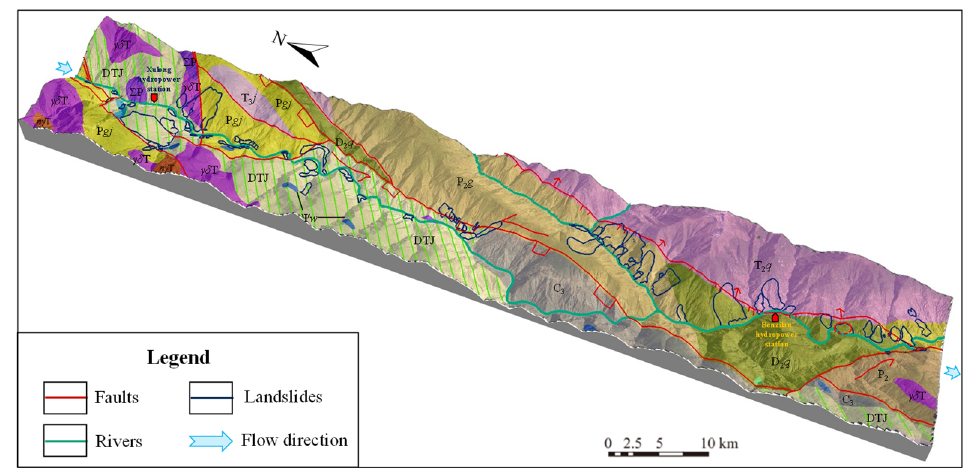
Figure 5. Landslide inventory data map and typical landslides in the study area.